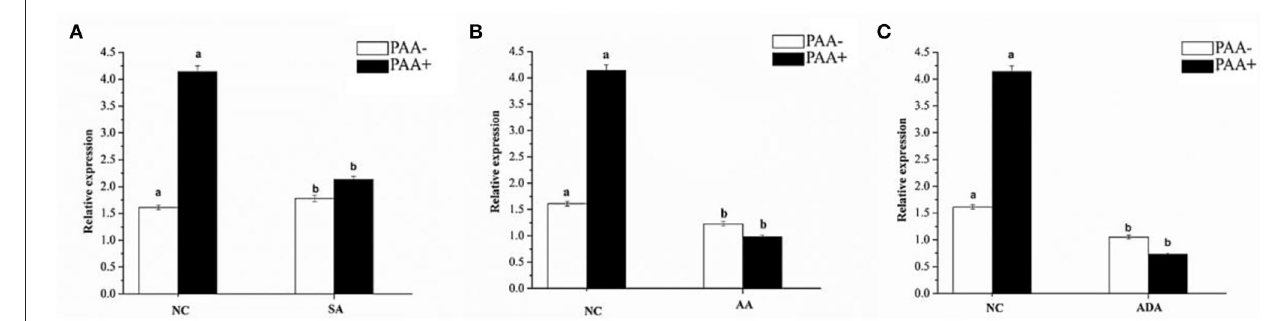
FIGURE 14 | Expression of abct 31 in M. ruber M7 to weak acid supplementation with or without PAA. NC was presented in the control group in which M. ruber M7 was cultivated on PDA without sorbic acid. SA presented the sorbic acid group in which M. ruber M7 was cultivated on a PDA with (A) Sorbic acid at 7.5Mm; (B) Acetic acid at 1.5Mm; (C) Adipic acid at 3mM. Both groups were incubated at 28 ◦ C for 7d in the presence (black vertical bar) and absence (empty vertical bar) of PAA at